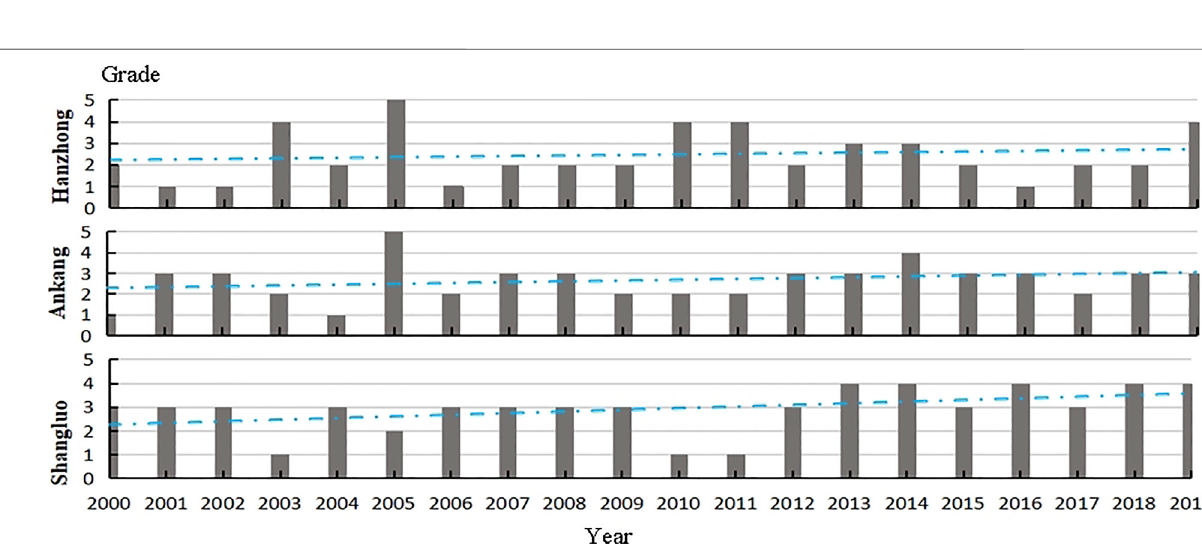
FIGURE 6 | Evaluation results of water resources value in three regions of Shaanxi